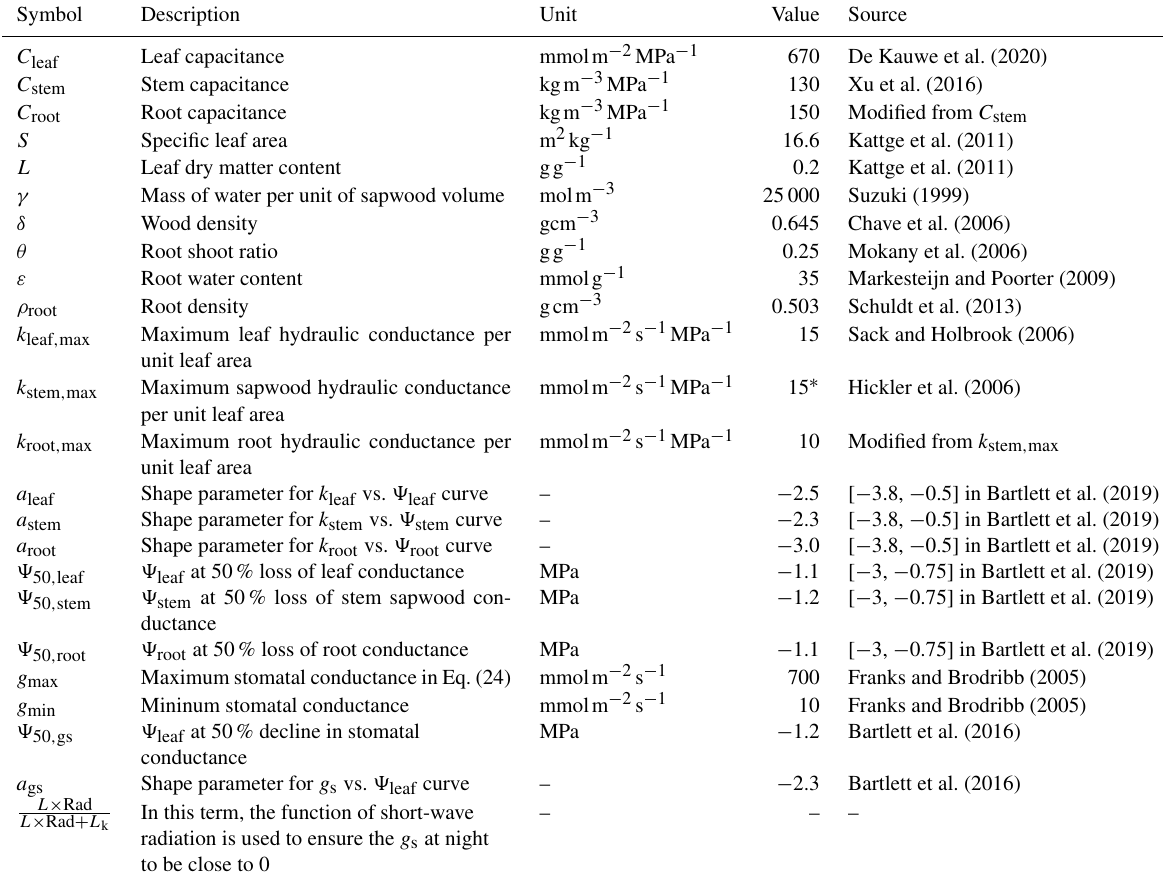
Table A2. Parameters used in the new hydraulic architecture model. These parameters are selected from the range recorded by literature that we have analyzed.